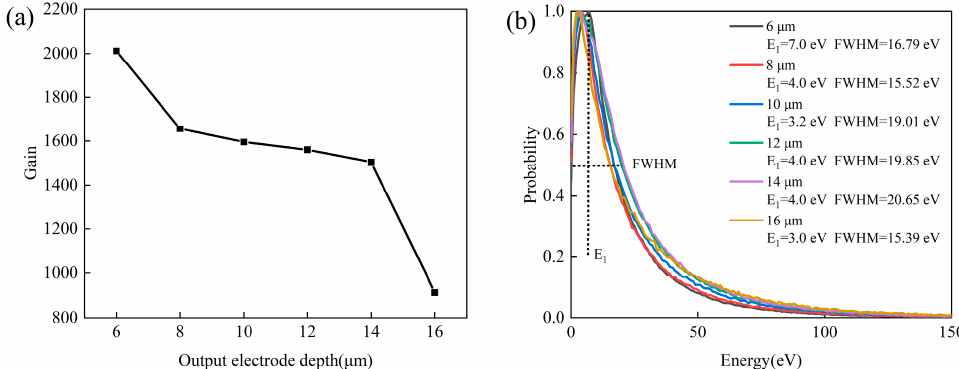
Figure 7. Effect of output ‒ electrode penetration depth on secondary electron multiplication (bias voltage = 900 V, L / D = 39, θ = 6°): ( a ) Gain; ( b ) The most probable exit energy distribution.